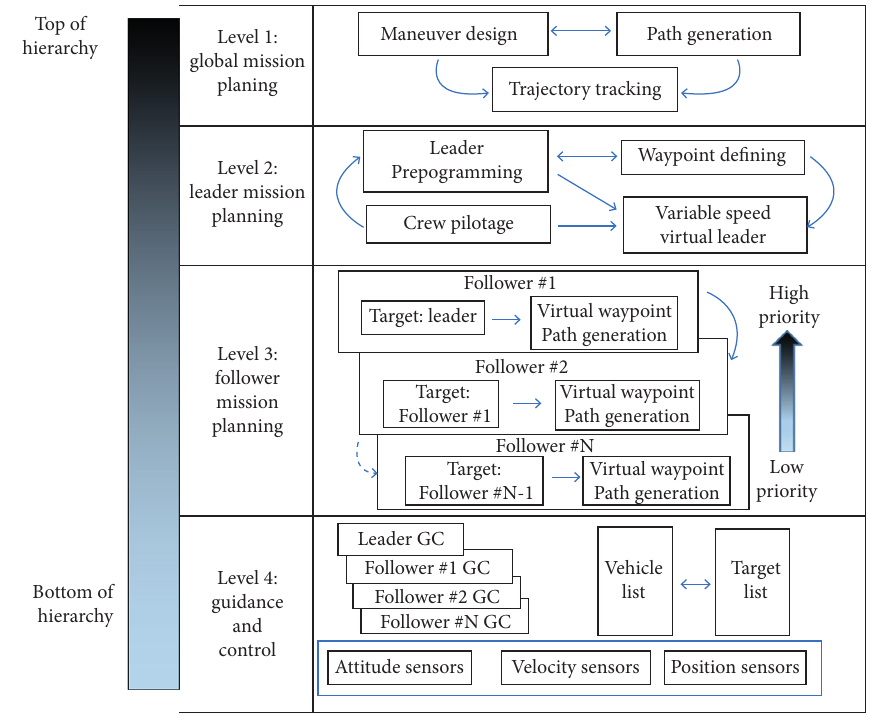
Figure 1. Hierarchical design of large-scale multi-vehicle autonomous